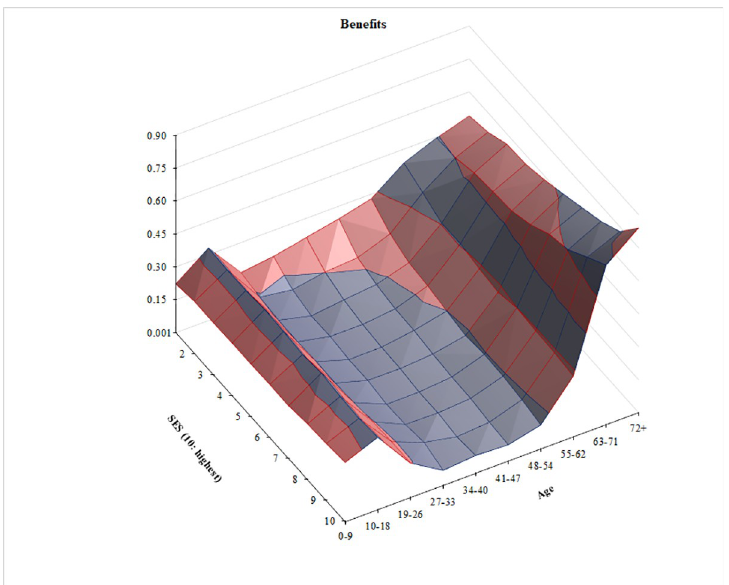
Fig 1. Per capita welfare benefits (cash and in-kind) by age and SES in the European Union. Source: Authors’ calculation. Notes: Calculated from a pooled sample of over 400,000 individuals from 22 EU countries. National values are re-scaled based on the average labor income of 30-49-year-olds. The image is rotated. https://doi.org/10.1371/journal.pone.0255760.g001 upward right riverbank for the young, especially the second-youngest decile (roughly consist- ing of teenagers). Then there is a wide riverbed among the working-aged (deepest among the fifth to seventh age deciles), and a steep left riverbank among the elderly (three oldest deciles).